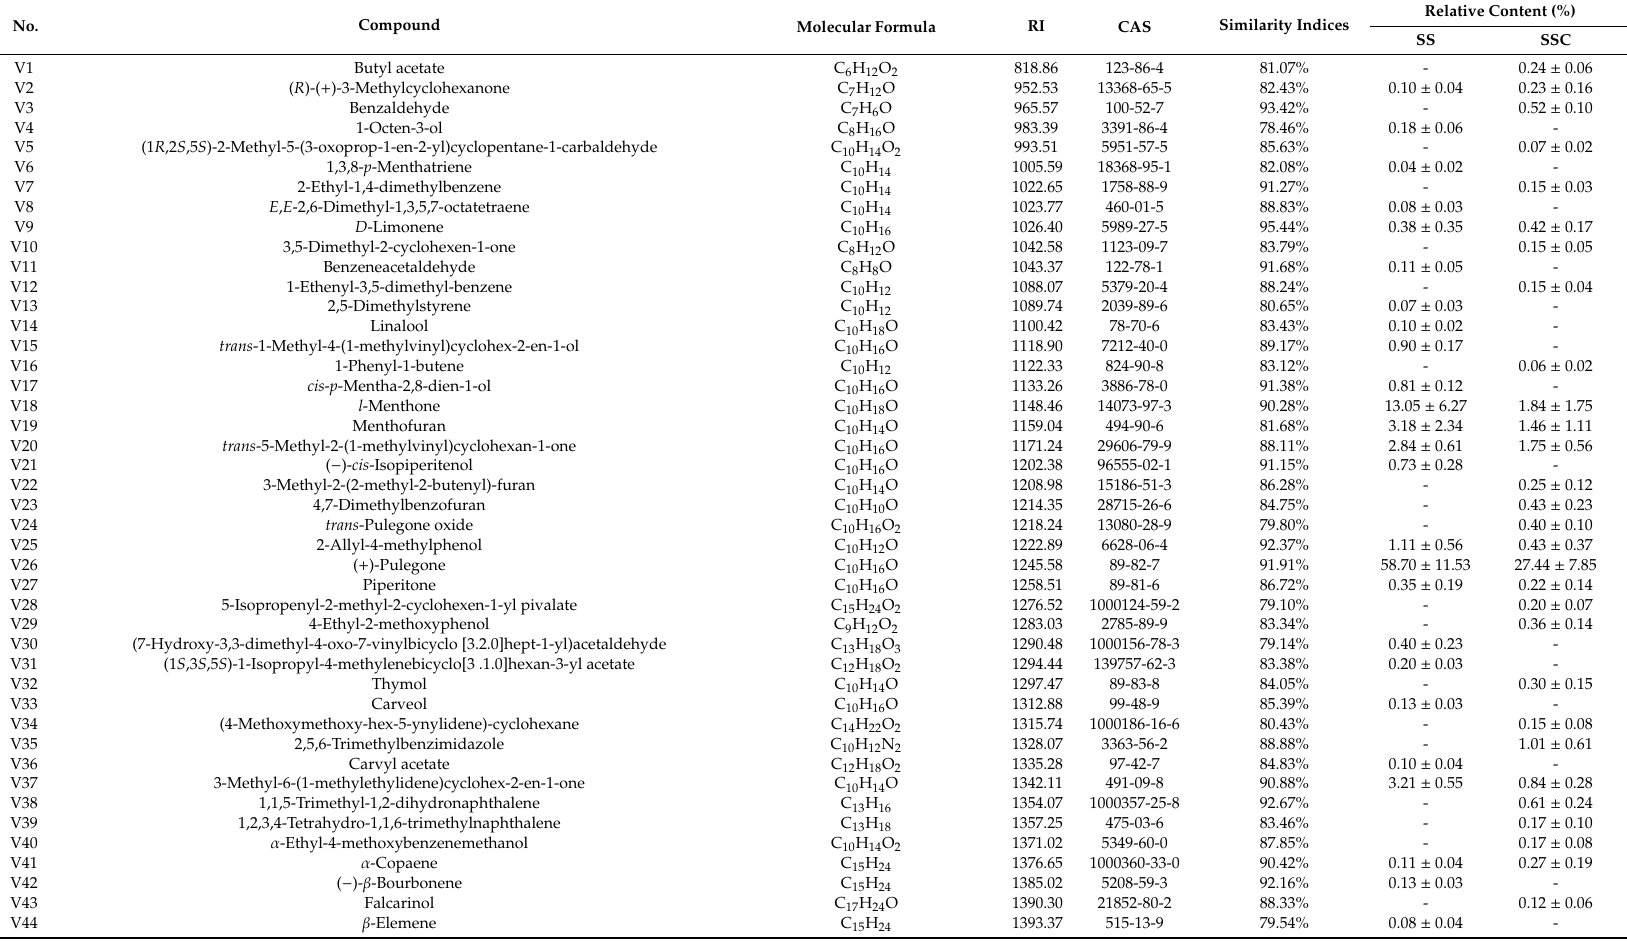
Table 2. Volatile compounds and their relative contents in SS and